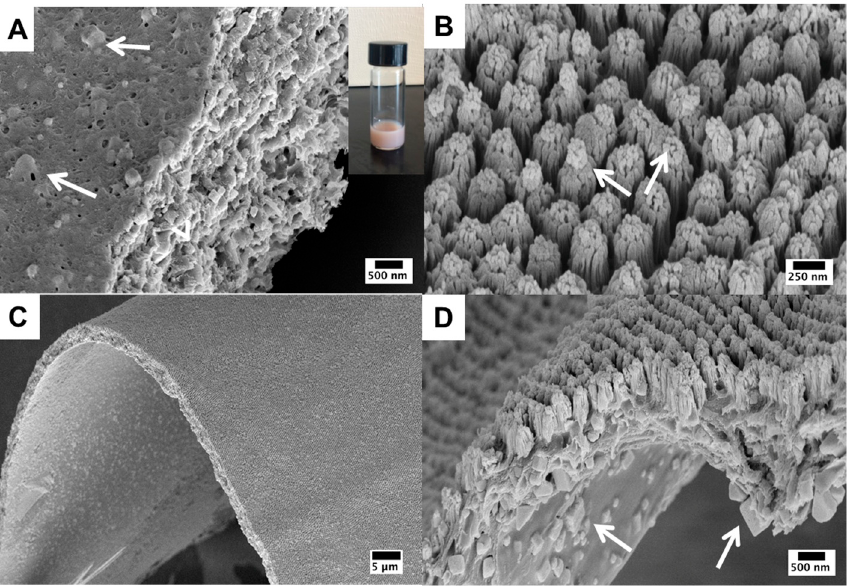
Figure 5. Nanostructured surfaces generated on a self-masking AgNP–chitosan thin film by colloidal-nanosphere lithography. ( A ) Chitosan–AgNP composite thin film generated by a chitosan– AgNP solution (inset); note the presence of cuboidal AgNP embedded within the film (denoted by arrows) ( B ) Post-reactive ion etch of the self-masked chitosan–AgNP composite thin film; note